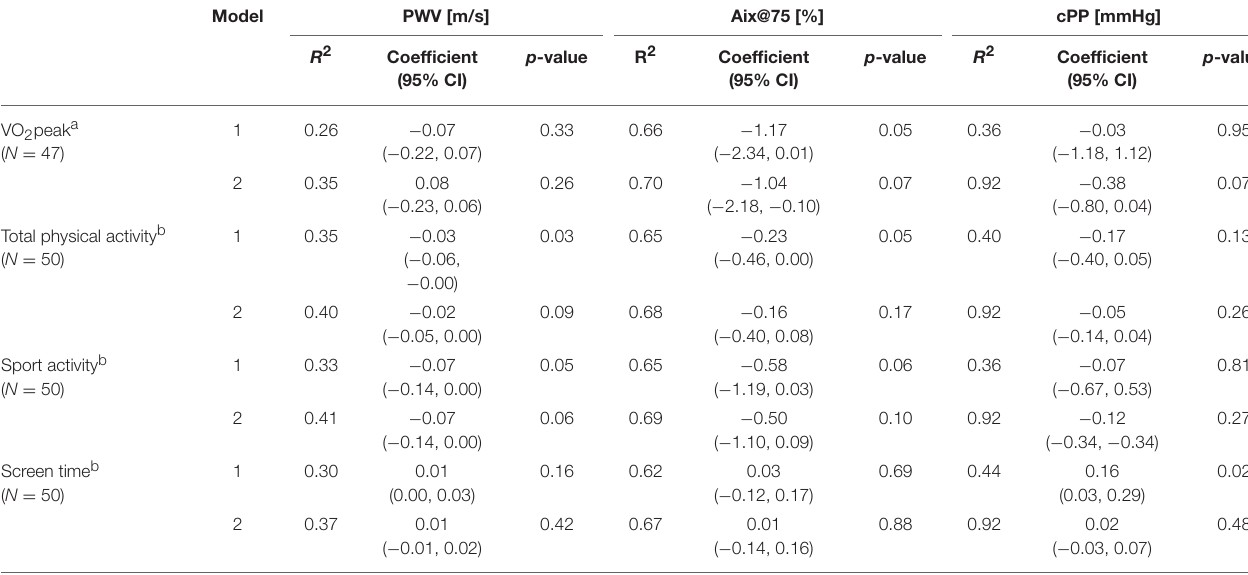
TABLE 4 | Influence of fitness and activity parameters on arterial stiffness. Model PWV [m/s] Aix@75 [%] cPP [mmHg] R 2 Coefficient (95%